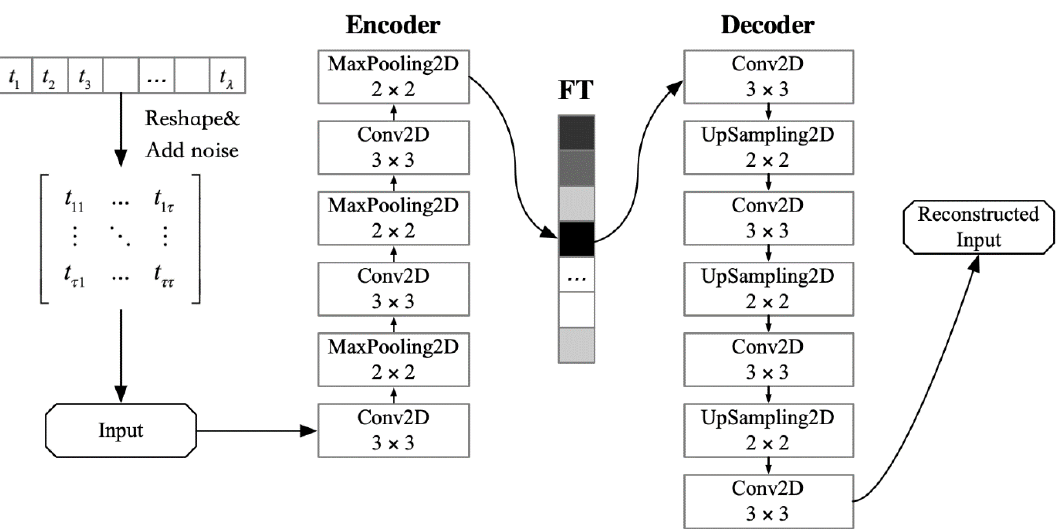
Figure 3. The structure of time-series denoising autoencoder (TSDA).